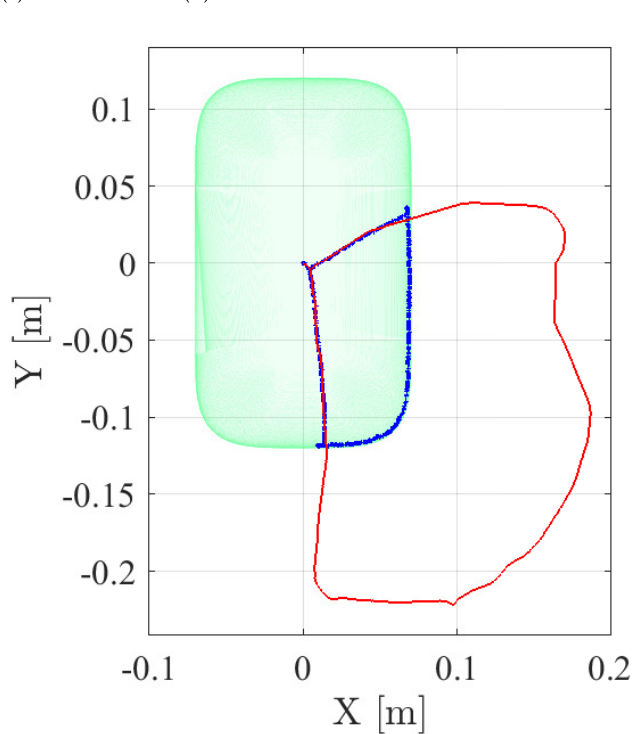
Figure 11. The 2D trajectory performance for the second experiment, showing the 2D boundary and the STR reference hologram (see the video at https://media.upv.es/player/?id=9504e6f0-8a61- trajectory followed by the user reference in thin red line; and trajectory followed by the STR tool in thick blue